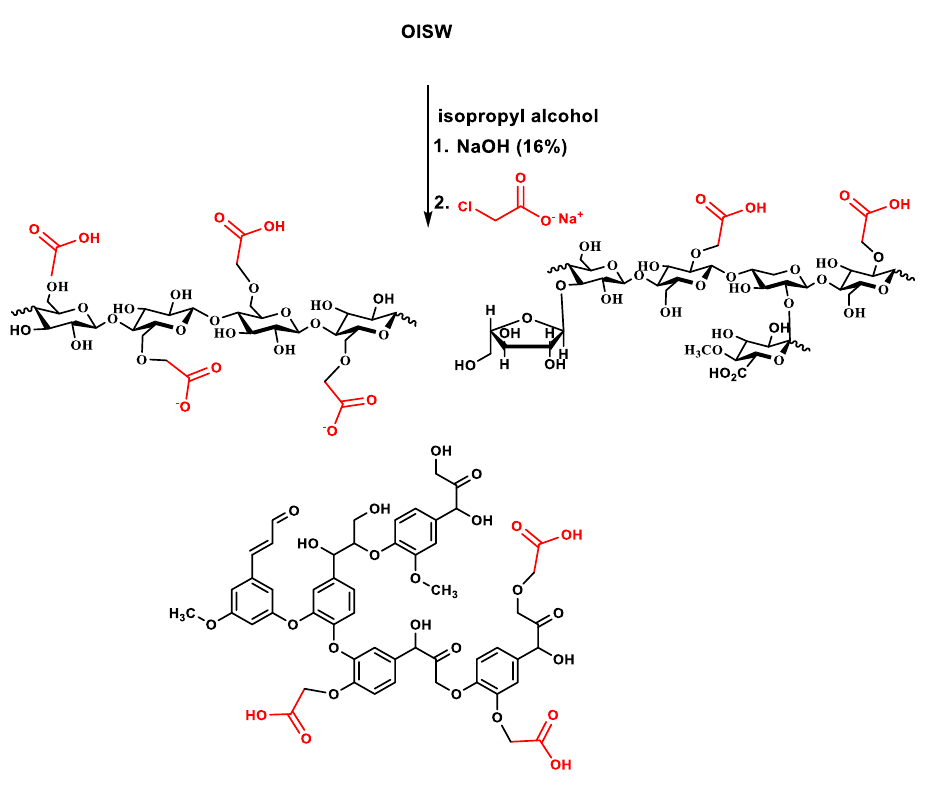
Figure 2. A summary of the carboxymethylation process of OISW.